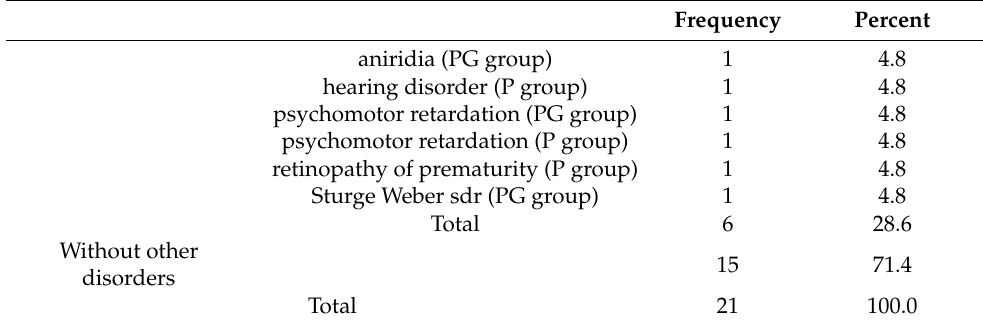
Table 5. Associated disorders.